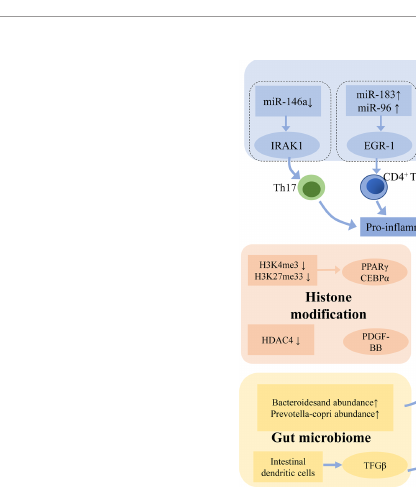
FIGURE 1 | Potential mechanism of epigenetics and gut microbiome in the pathogenesis of GO. Abnormal epigenetic modi fi cations may promote pro-in fl ammatory cascades and disrupt the expression of signaling molecules that are involved in the fi brogenesis and adipogenesis of orbital fi broblasts. Gut microbiome possibly drives the pathogenesis of GO by in fl uencing secretion of TRAb and Th17/Treg imbalance. The process of all these changes will lead to the hyaluronan production and the activation of orbital fi broblasts, which eventually develop into tissue expansion, fi brosis and in fl ammation. LMG, lowly methylated genes; HMG, highly methylated genes; TRAb, Thyrotropin receptor antibody; Treg, regulatory T; Th17, T-helper